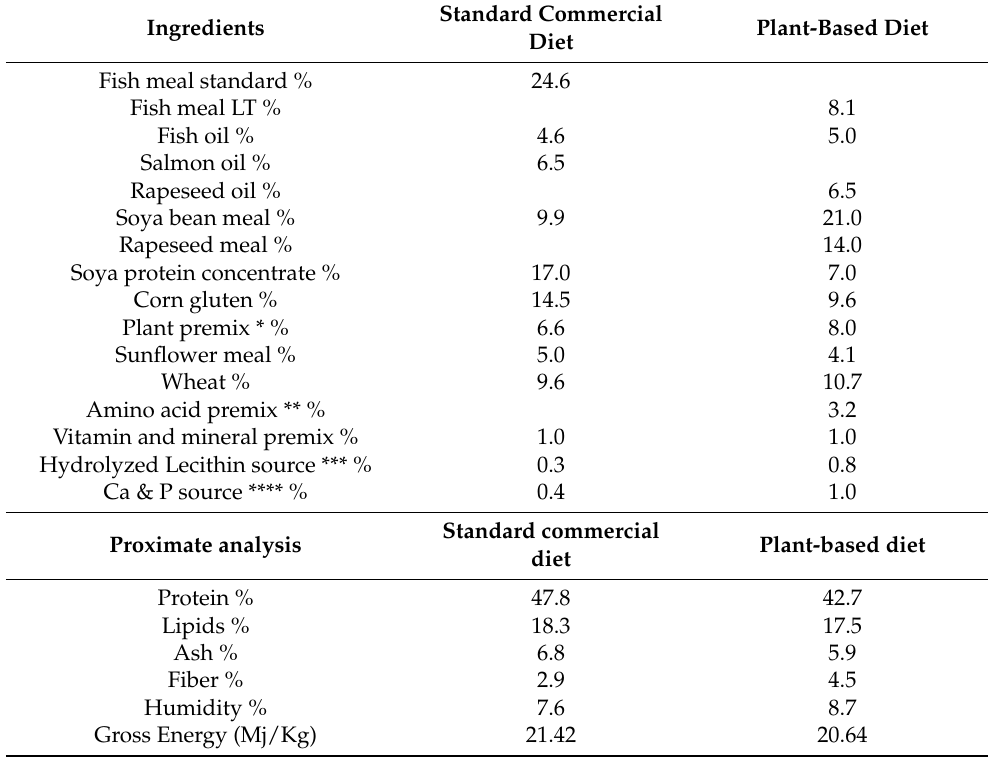
Table 1. The raw materials and approximate composition (AOAC, 2003) of the standard commercial and plant-based diets. The comparative composition of the standard commercial diet and the plant- based diet is provided. Amino acids, fish oil and phospholipids were supplemented in both diets to meet the nutritional needs of gilthead sea